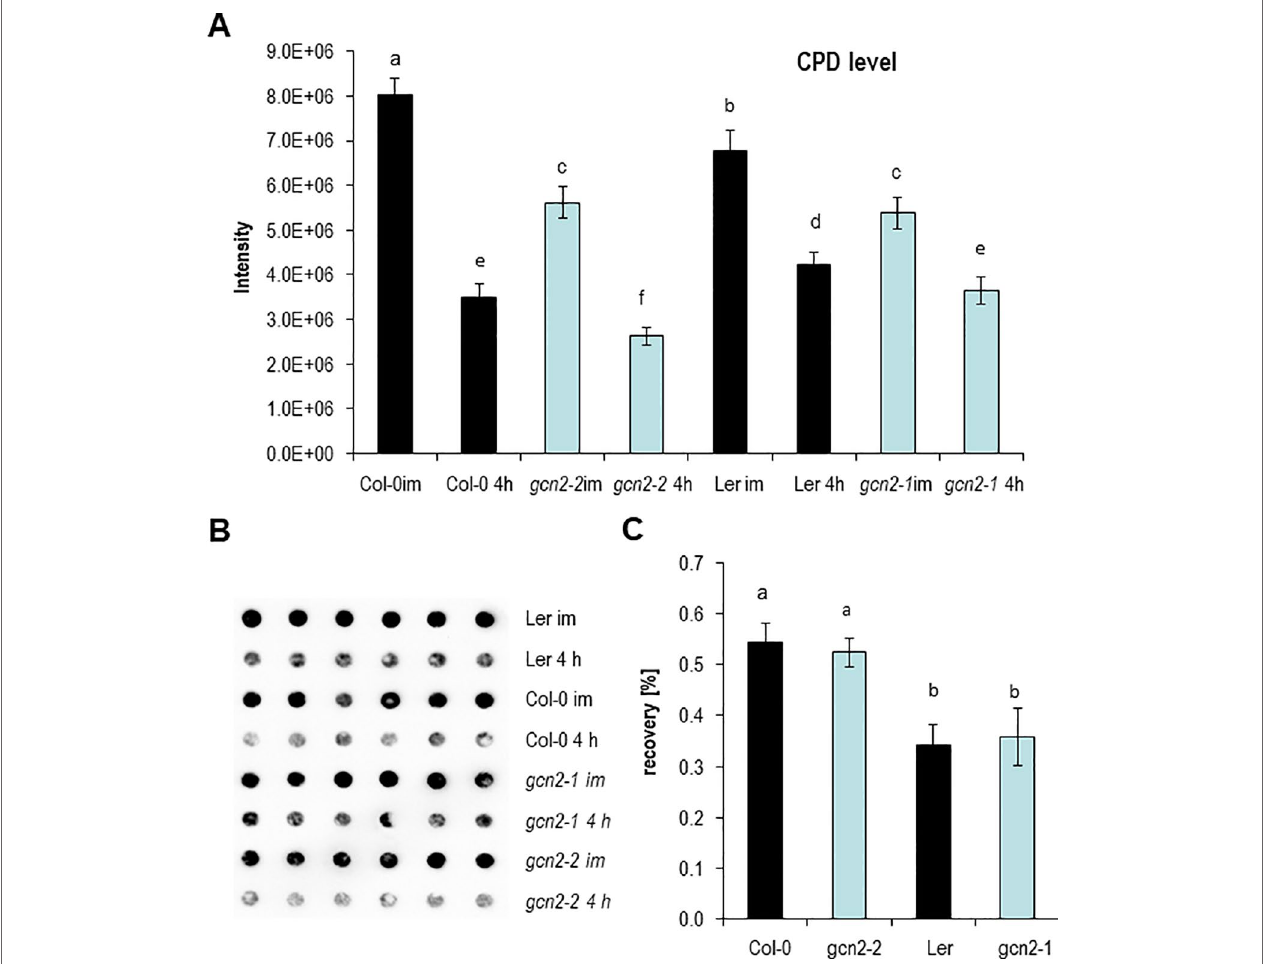
FIGURe 4 | DNA damage and repair analysis. (A) Absolute CPD levels of plants harvested immediately after 1 h UV-B exposure and 4 h after UV-B shut down. (B) Representative image of a genomic DNA dot blot hybridized with anti-CPD antibodies. (C) Calculated recovery after UV-B exposure. Graphs represents means and ± SE of three to five experiments (six dots per experiment). Letters indicate the significant